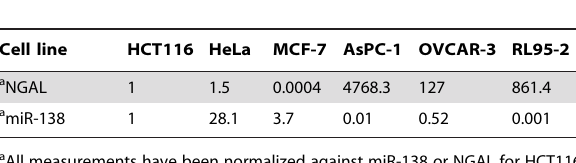
Table 1. Relative expression levels of NGAL mRNA and miR- 138 in various cancer cell lines determined by